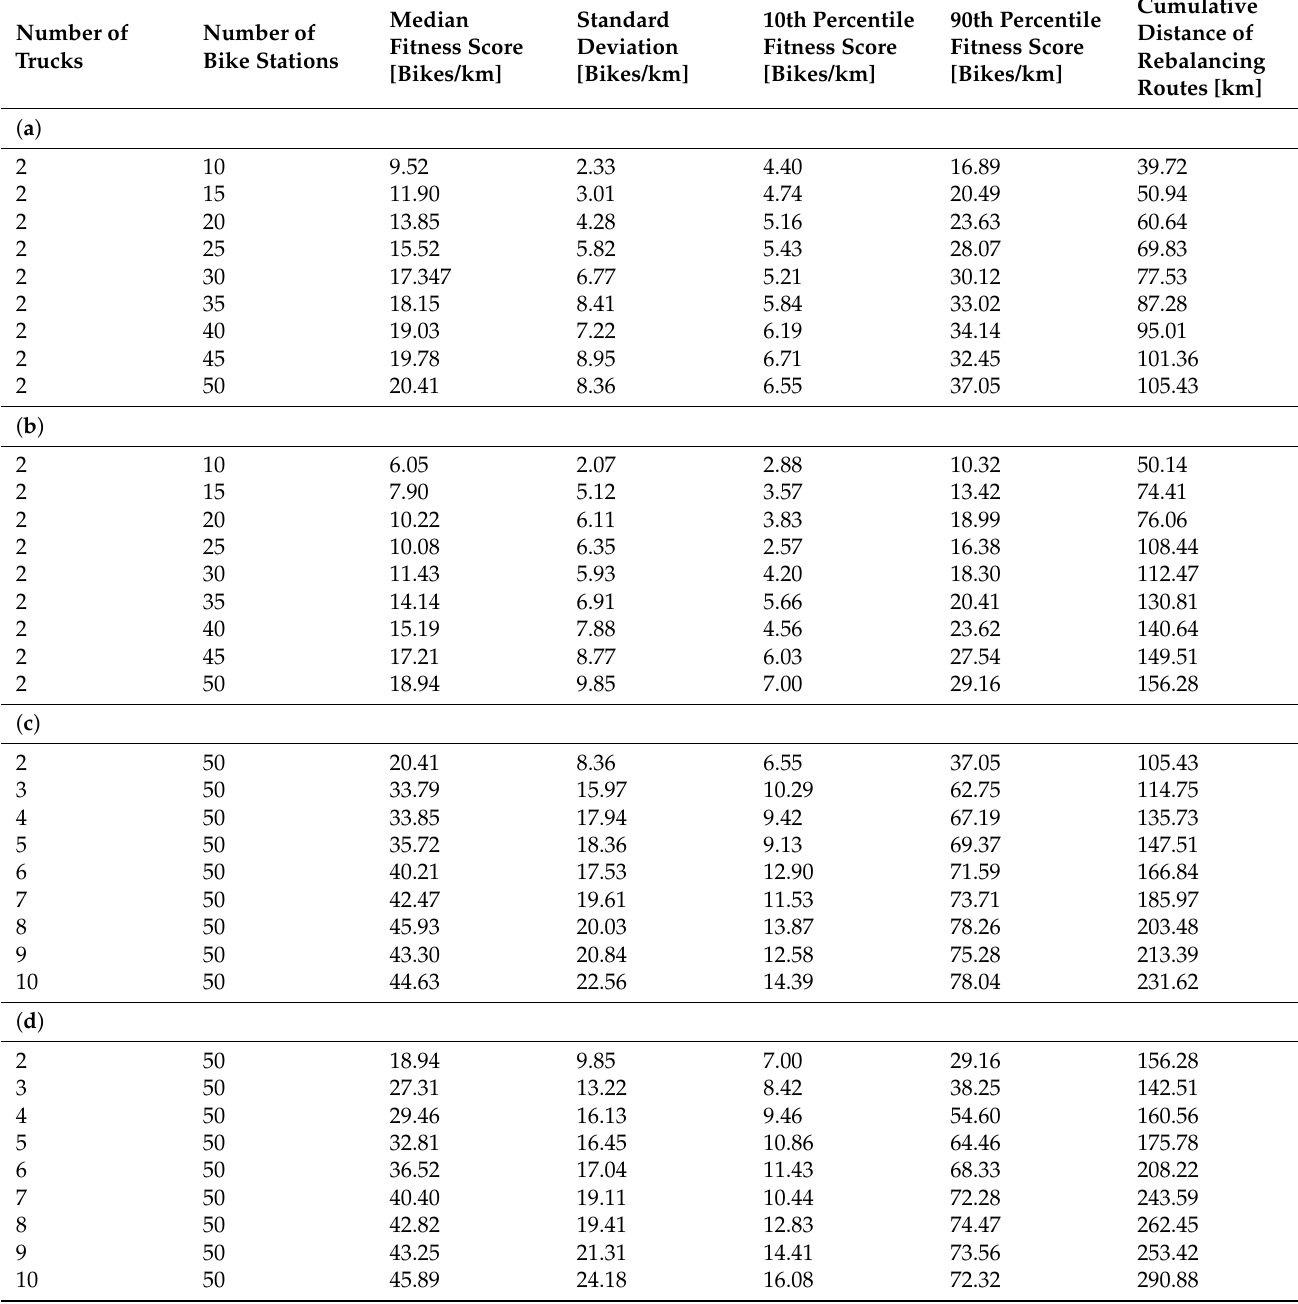
Table 8. ( a ) Performance of the FLCGA for different numbers of bike stations to rebalance. ( b ) Performance of the TSA for different numbers of bike stations to rebalance. ( c ) Performance of the FLCGA for different numbers of rebalancing trucks. ( d ) Performance of the TSA for different numbers of rebalancing